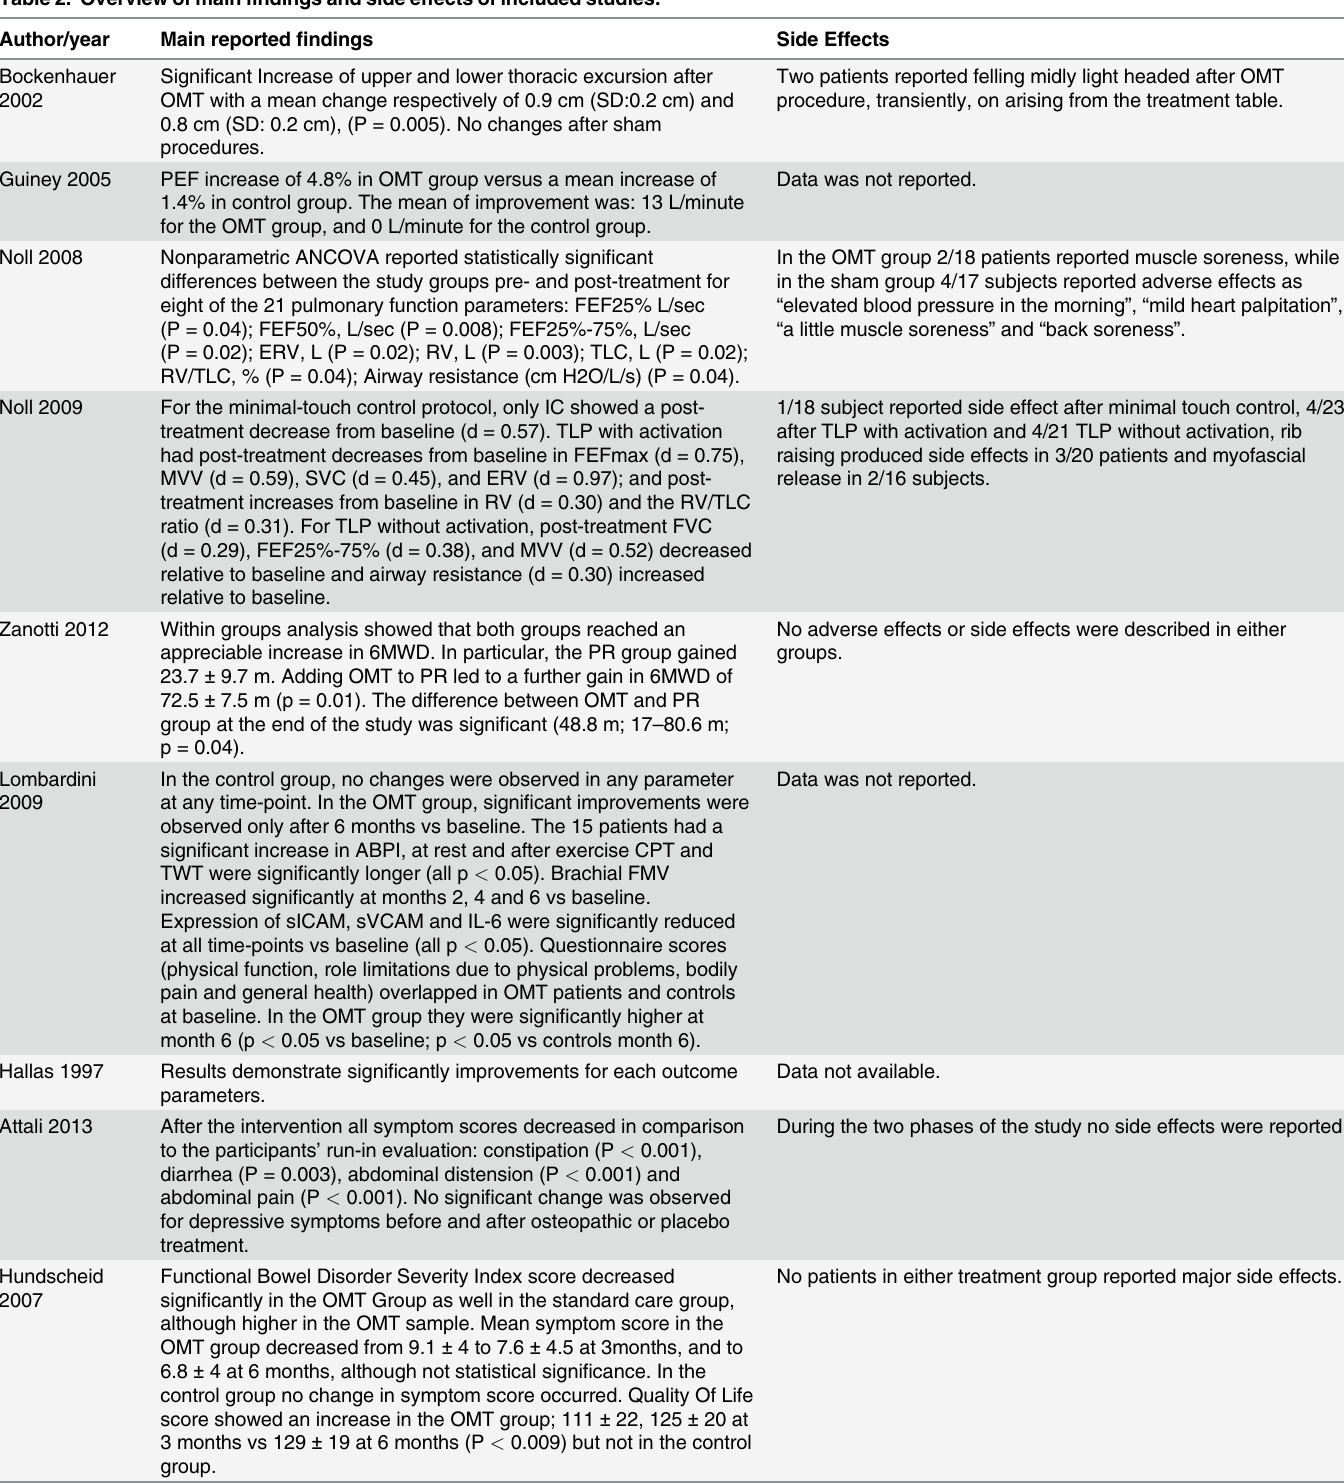
Table 2. Overview of main findings and side effects of included